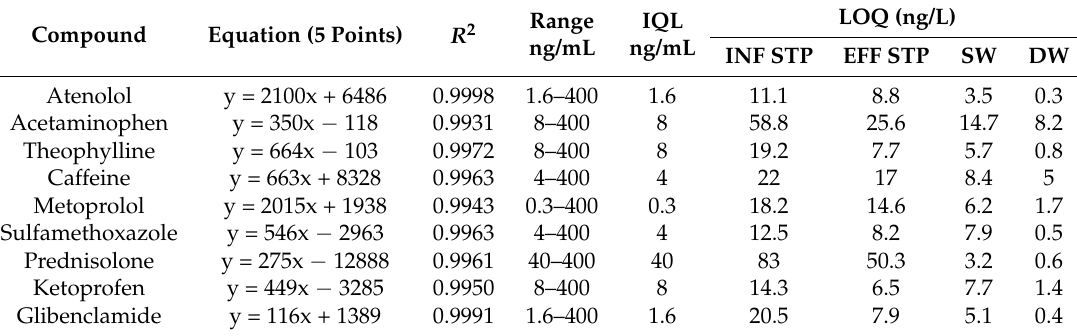
Table 3. Method validation